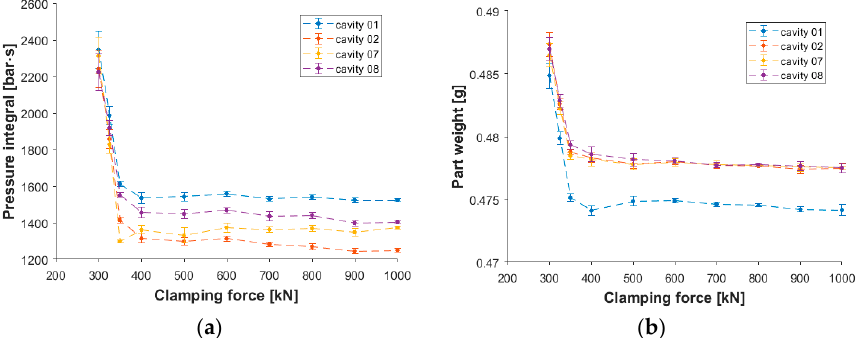
Figure 3. The change of the pressure integral ( a ) and part weight ( b ) of the inner (07 and 08) and outer (01 and 02) cavities due to a change in the clamping